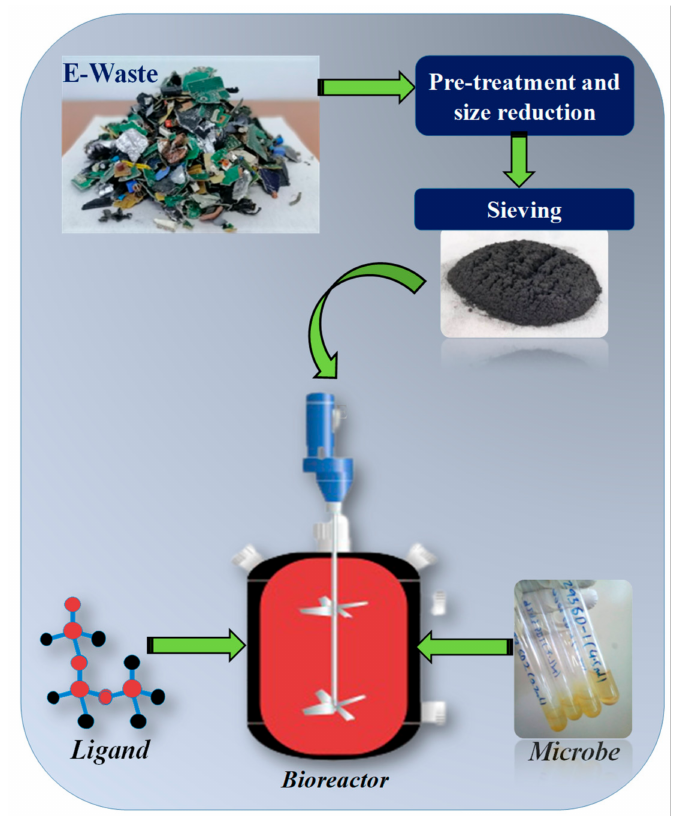
Figure 7. Pictorial representation of a ligand mediated integrated bioleaching